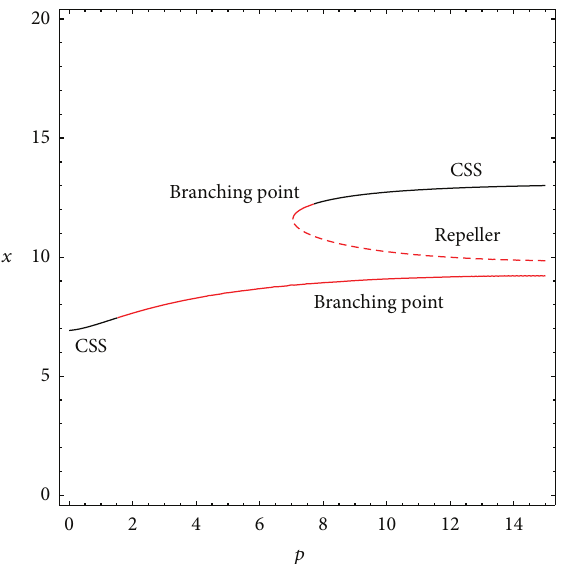
Figure 2: Bifurcation diagram for evolutionarily singular strategy 𝑥 and recovery disturbance strength 𝑝 . Red solid lines indicate unstable singular strategy 𝑥 (i.e., evolutionary branching point), black solid lines indicate the CSS, and red dashed line indicates the repeller. The parameter values are 𝑎 = 200 , 𝑏 = 10 , 𝜇 = 6 , 𝜎 = 10 , 𝑐 = 2 , V = 0.8 , 𝐾 = 0.3 , and 𝜆 = 10.25